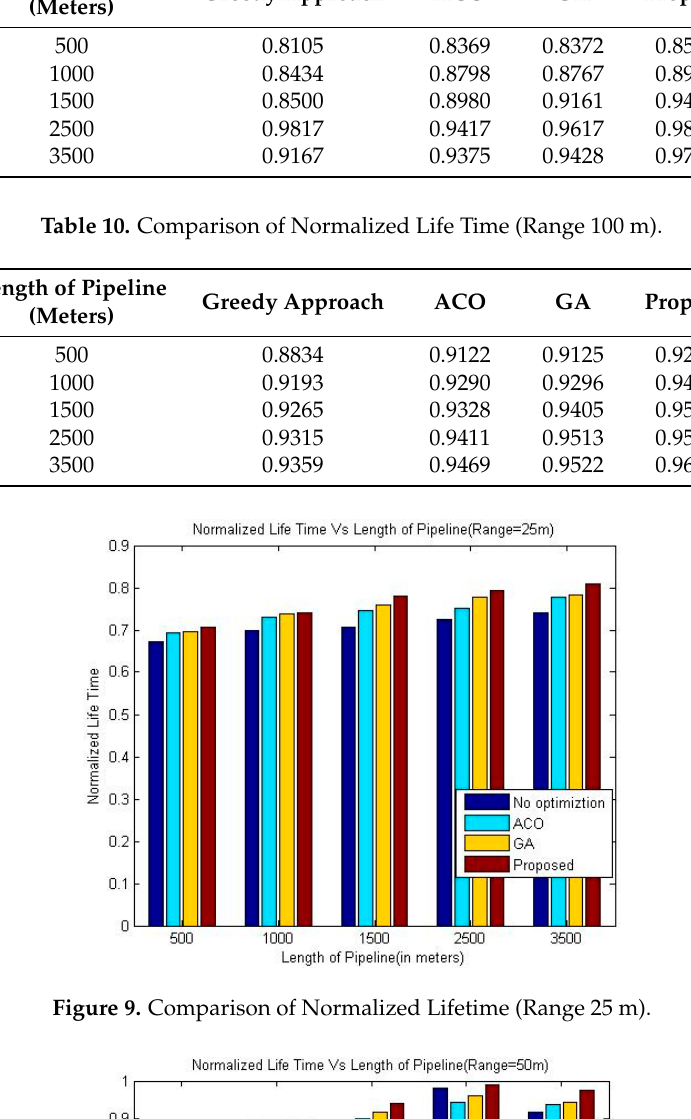
Table 8. Comparison of Normalized Life Time (Range 25 m).